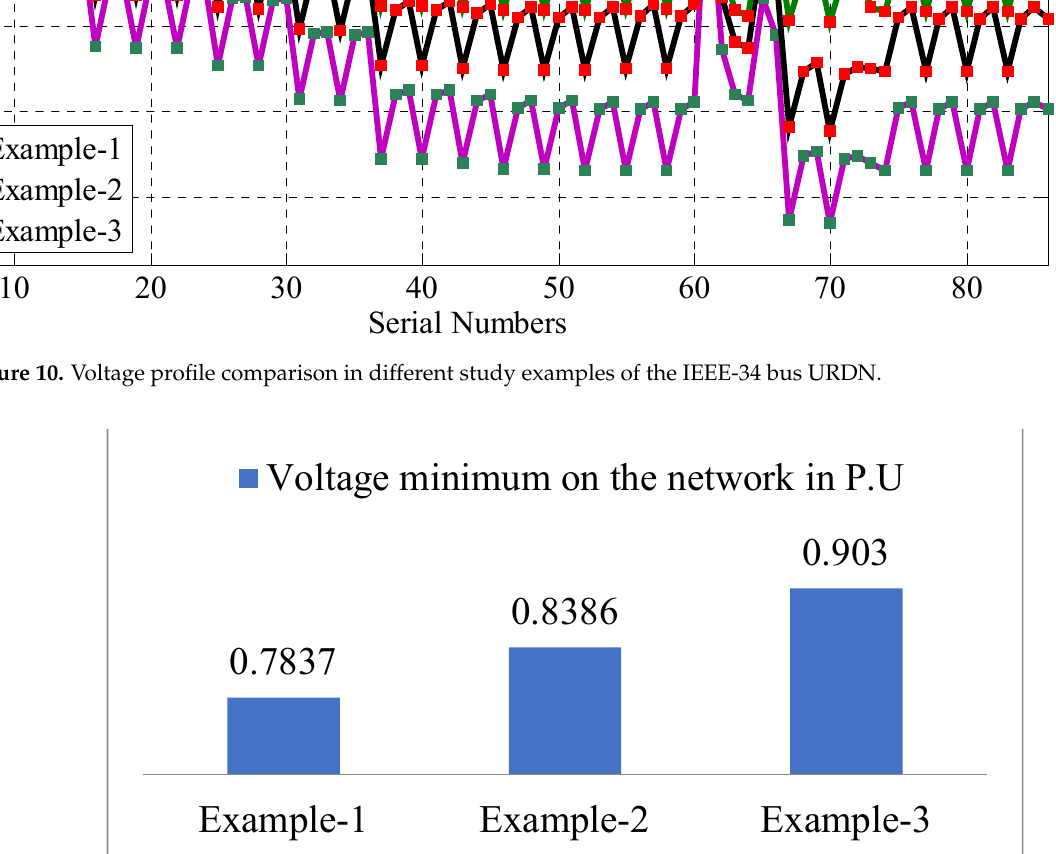
Figure 11. Voltage minimum in different study examples of the IEEE-34 bus